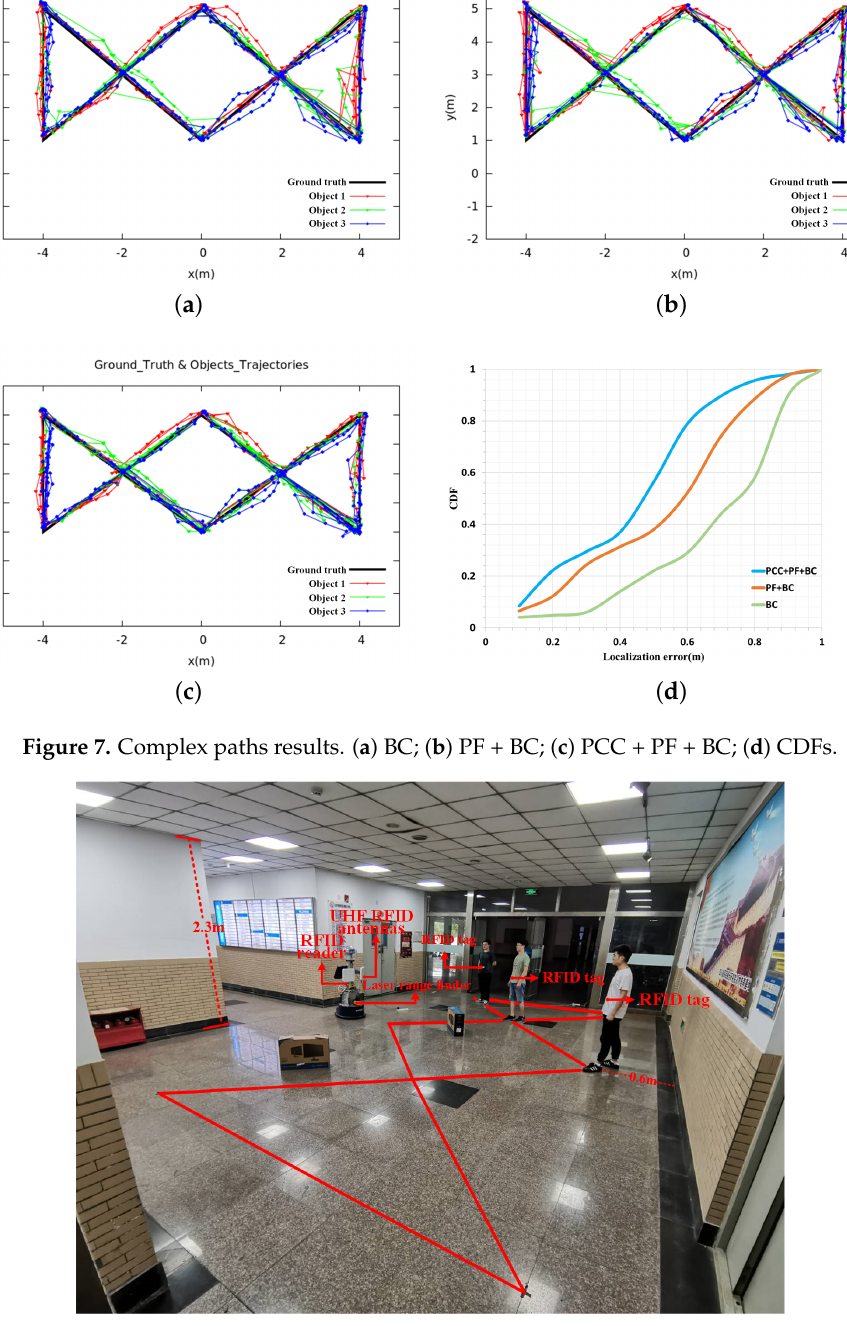
Figure 8. Experimental setup of complex path in indoor